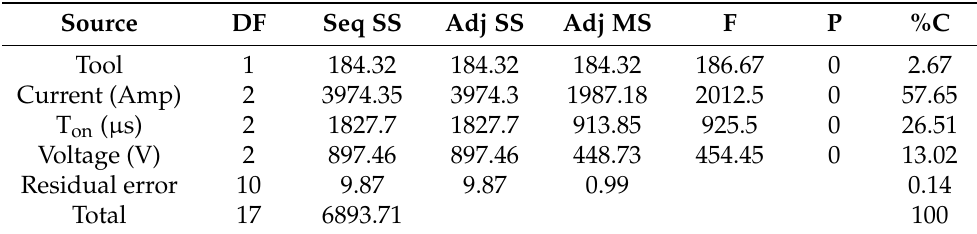
Table 5. Analysis of variance (ANOVA) for